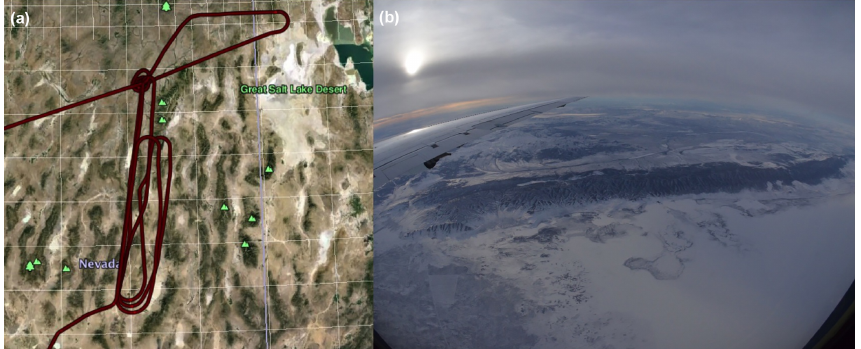
Figure 24. (a) Map of the ground track for the 2016 snow flight made over northeastern Nevada. The spiral-down location was centered on the airport at Elko NV and all subsequent measurements were made during the north–south tracks south of Elko. (b) Photograph of the snow covered hills and desert floor made during the 2016 snow